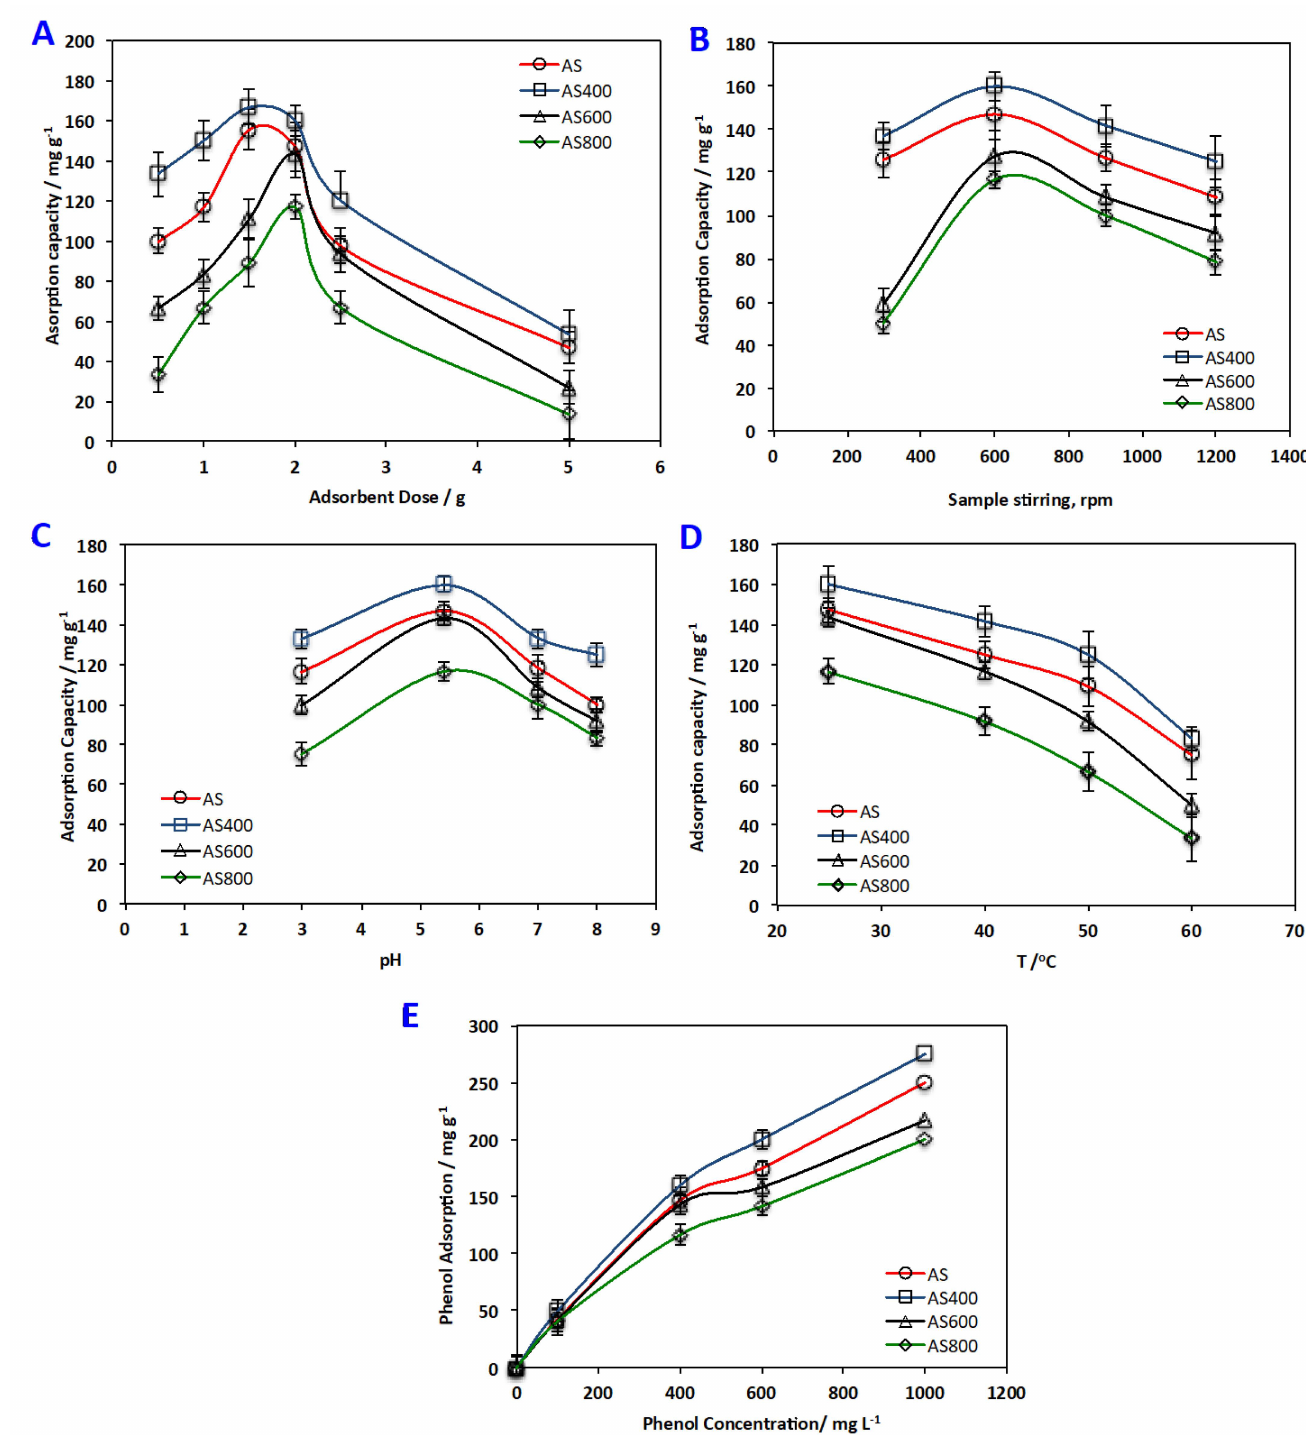
Figure 7. Effect of ( A ) adsorbent dose( B )sample stirring ( C ) pH ( D ) temperature and ( E ) phenol